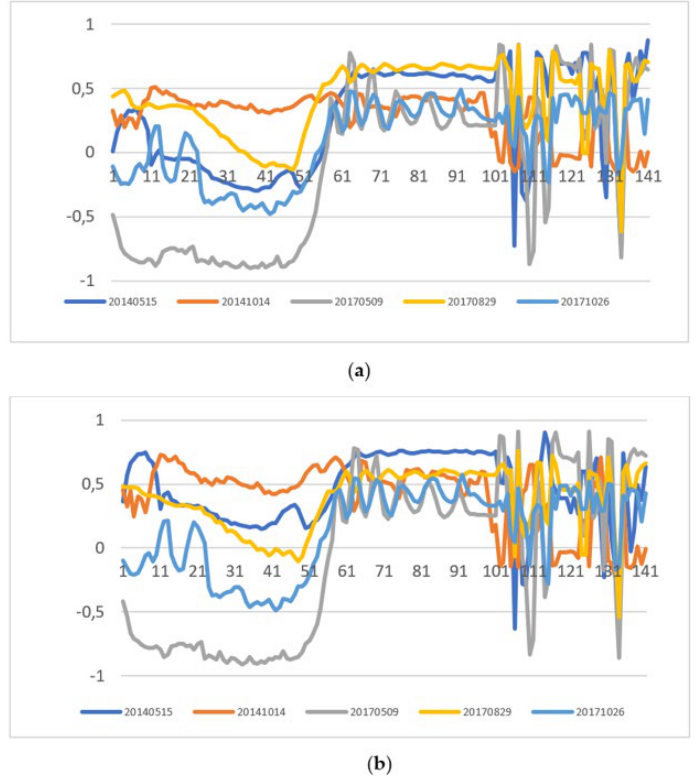
Figure 6. Linear correlation coefficient trends against the available ground data relevant with ( a ) dry mass and ( b ) nitrogen content. Indices on the x-axis from 1 to 101 refers to spectral bands. Those ranging from 102 to 141 correspond to the vegetation indices listed in Table 1. Table 4. Variables used for regression determined via VIP scoring. NVIP stands for number of VIP variables.